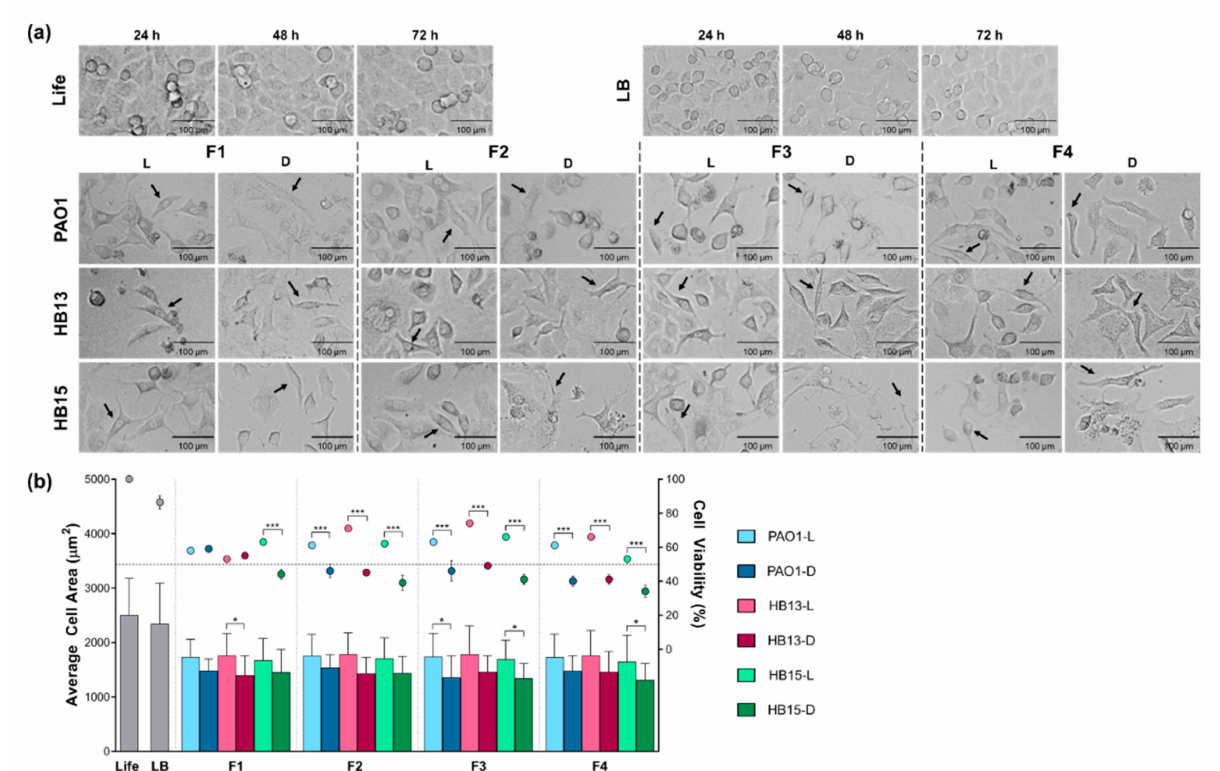
Figure 3. Effects induced in A549 cells by fractions of P. aeruginosa grown in constant exposure to full-spectrum light (L) and total absence of light (D). Four freshly collected fractions were screened: the cytosolic fraction (F1), the whole supernatant (F2), the further fractioned soluble portion (F3), and the OMVs fraction (F4). ( a ) Morphologic alterations induced in A549 cells by a specific fraction concentration (Table 1) at 48 h endpoint. A representative Life and LB control for the three MTT endpoints is presented. Arrows highlight few examples of cells representing a possible transition to a mesenchymal-like state. The scale bar is set for 100 µ m. Full contrast phase microscope shot available in Supplementary Figure S5. ( b ) Graphical representation of determined average area (bars) and viability (circles) of A549 cells. A horizontal line highlights a cellular viability of 50%. Standard deviation bars are represented. Statistical comparisons performed by two-way ANOVA, followed by Tukey’s post hoc test for multiple comparisons. Significant differences comparing the two growth conditions are indicated as: * p < 0.05, *** p <